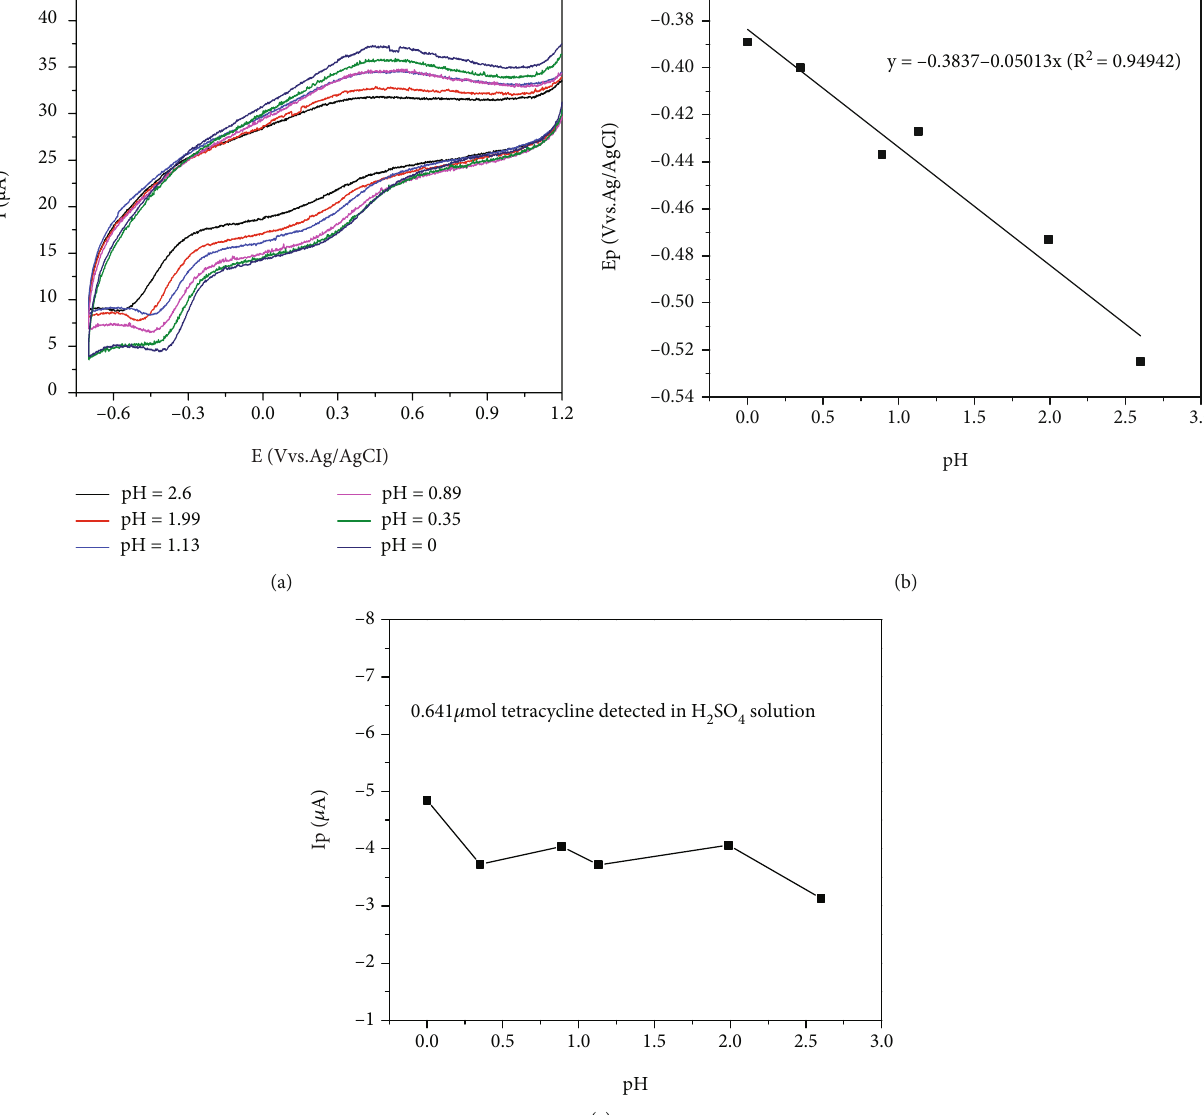
SO solution with di ff erent pH values (0-2.6). (b) The dependence 2 4